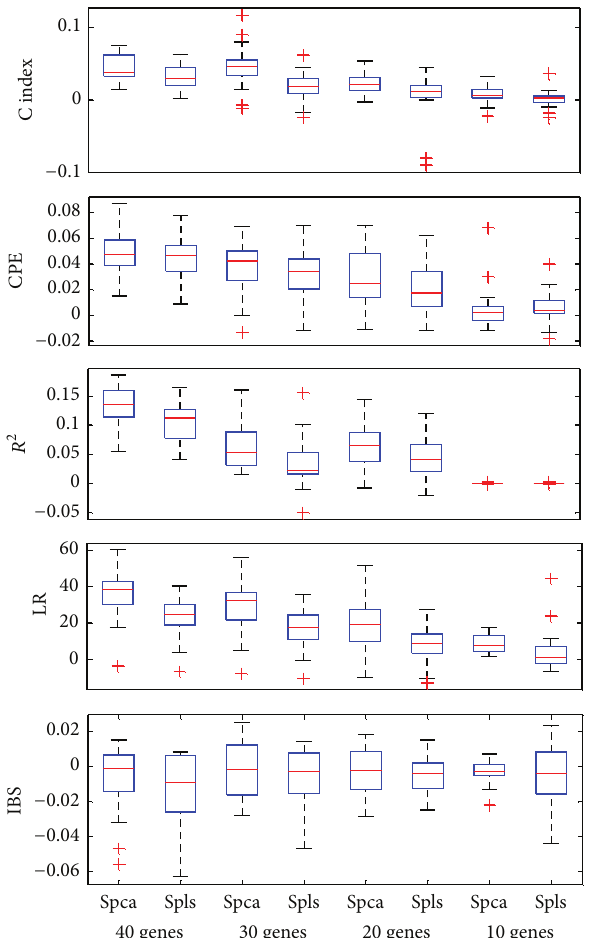
Figure 3: Box plot of the difference in model evaluation criteria between the supervised wavelet and the two other methods for DLBCL dataset with different number of preselected